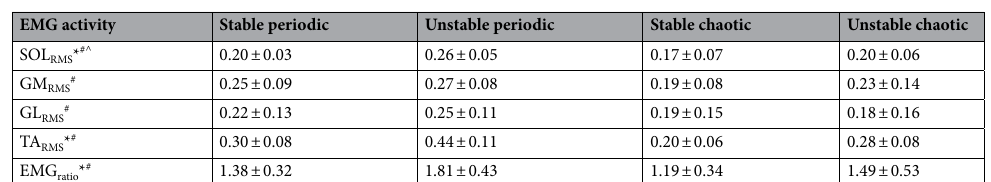
Table 2. EMG behaviour: RMS values of the EMG signal from the soleus (SOL RMS ), gastrocnemius medialis (GM RMS and TS RMS (with the TS being referred to the triceps surae muscle calculated as the average activity of GM, GL and SOL) for the four examined postural tasks of varying surface (stable-rigid and unstable-foam) and target complexity (periodic-sinusoidal and chaotic-Lorenz). Values are presented in mean ± standard deviation. *Significant surface effect (stable vs. unstable) (p < 0.05). # Significant target complexity effect (periodic vs. chaotic) (p < 0.05). ^ Significant interaction between surface and target (p < 0.05).